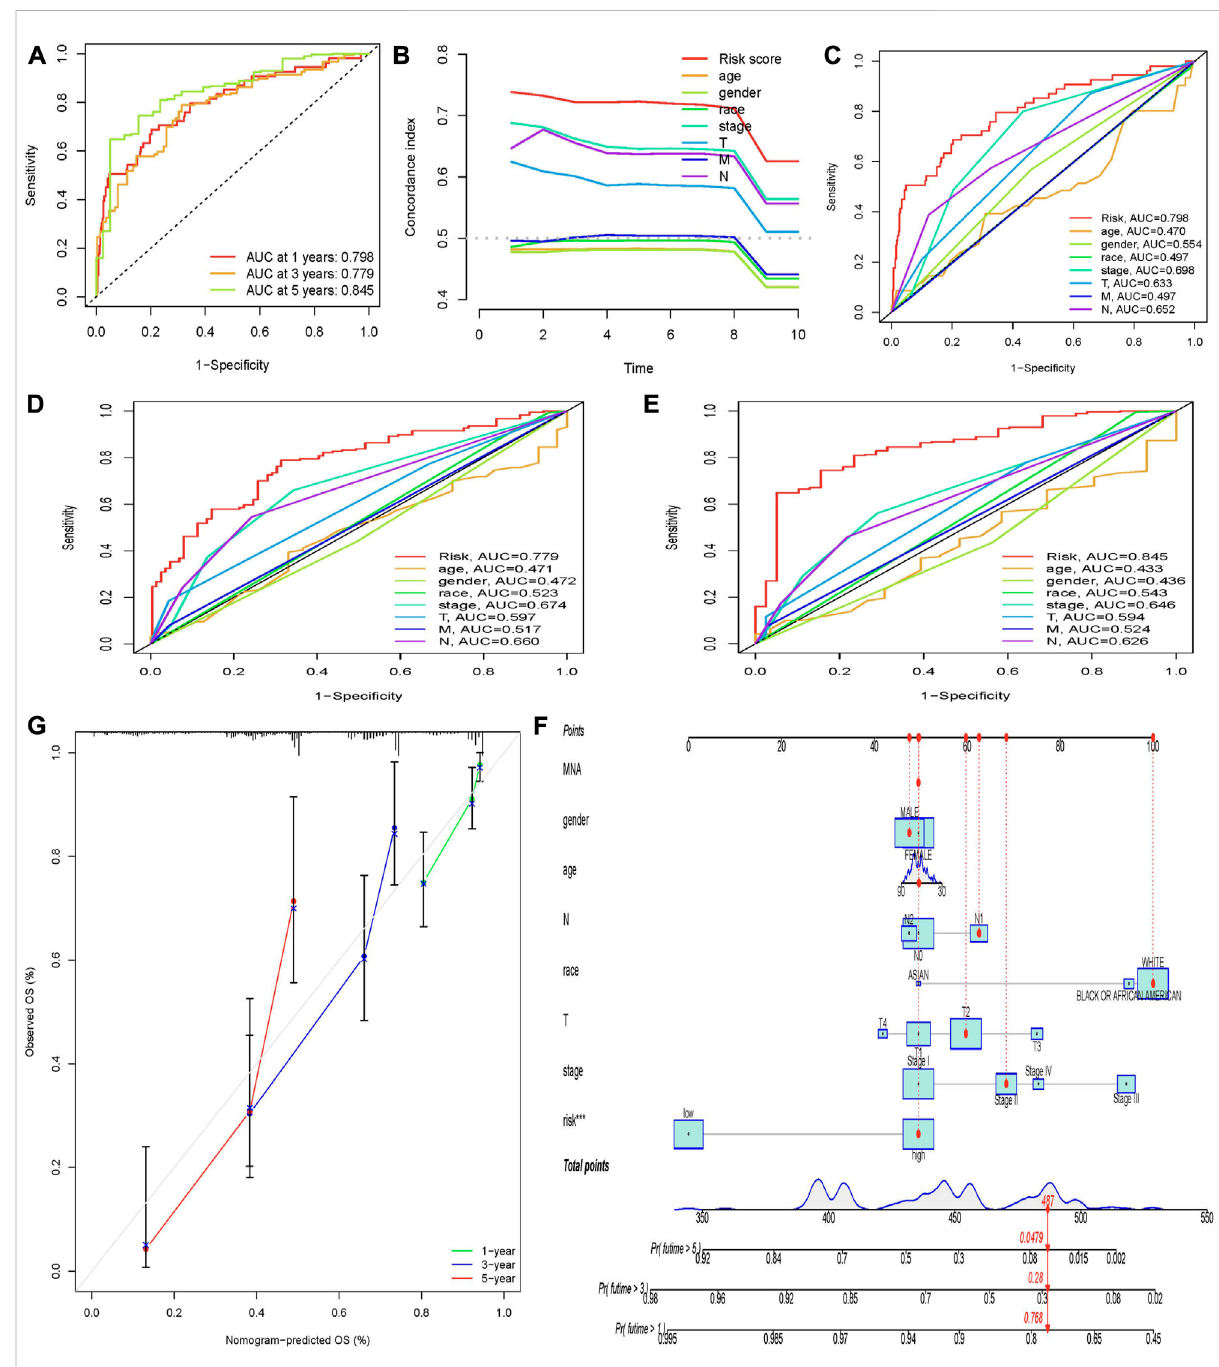
FIGURE 3 Evaluation of prognostic models and establishment of a nomogram. (A) AUC values of the prognostic model of molecular chaperones-related lncRNAs at 1, 3, and 5 years. The abscissa represents 1-speci fi city and the ordinate represents sensitivity. Interpretation of AUC results: AUC ≤ 0.5 indicates no predictive power. 0.5 < AUC ≤ 0.7 indicates low prediction accuracy. 0.7 < AUC ≤ 0.9 indicates moderate prediction accuracy. AUC > 0.9 indicates high prediction accuracy. (B) C-index curve to assess the quality of a patient ’ s clinically independent prognostic model. (C – E) Calculate the AUC for risk score, age, gender, grade, and TNM stage of the total survival risk score according to 1-, 3-, and 5-year ROC curve. (F) Nomogram predicts 1-, 3-, and 5-year OS survival in patients with LUAD. (G) Calibration curve for nomogram. The x -axis is the nomogram predicted survival and the y -axis is the actual